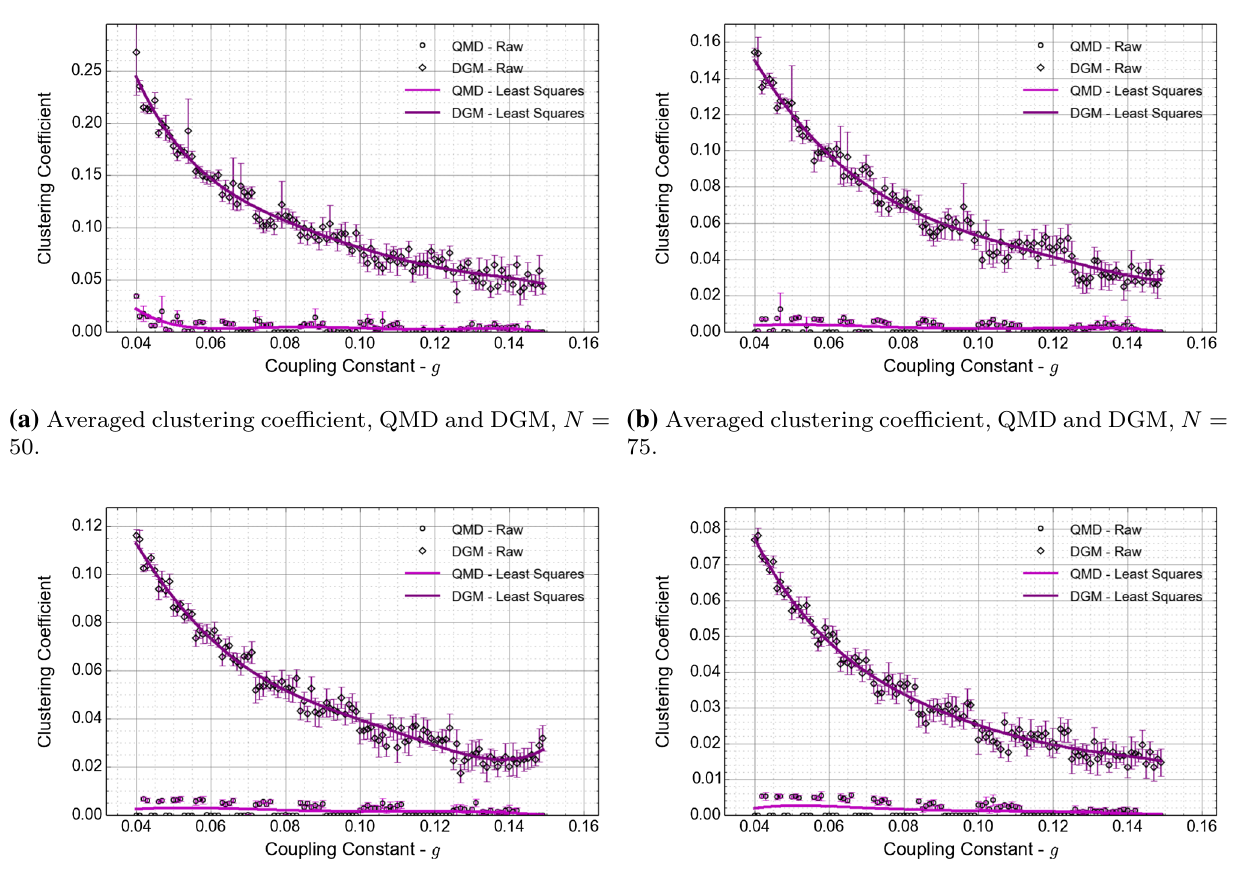
Fig. 3 Comparison of both QMD and DGM clustering coefficients across a range of graph sizes. Each datapoint represents the average value across 10 graph samples. Against each of the data points the error